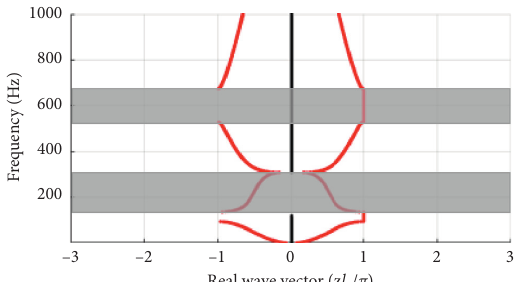
Figure 6: Band structure obtained by solving equation (24) to investigate the wave attenuation capabilities of the metamaterial structure. First and second frequency bandgaps are 121–310Hz (lower frequency range) and 528–674Hz (higher frequency range), respectively (marked in gray).